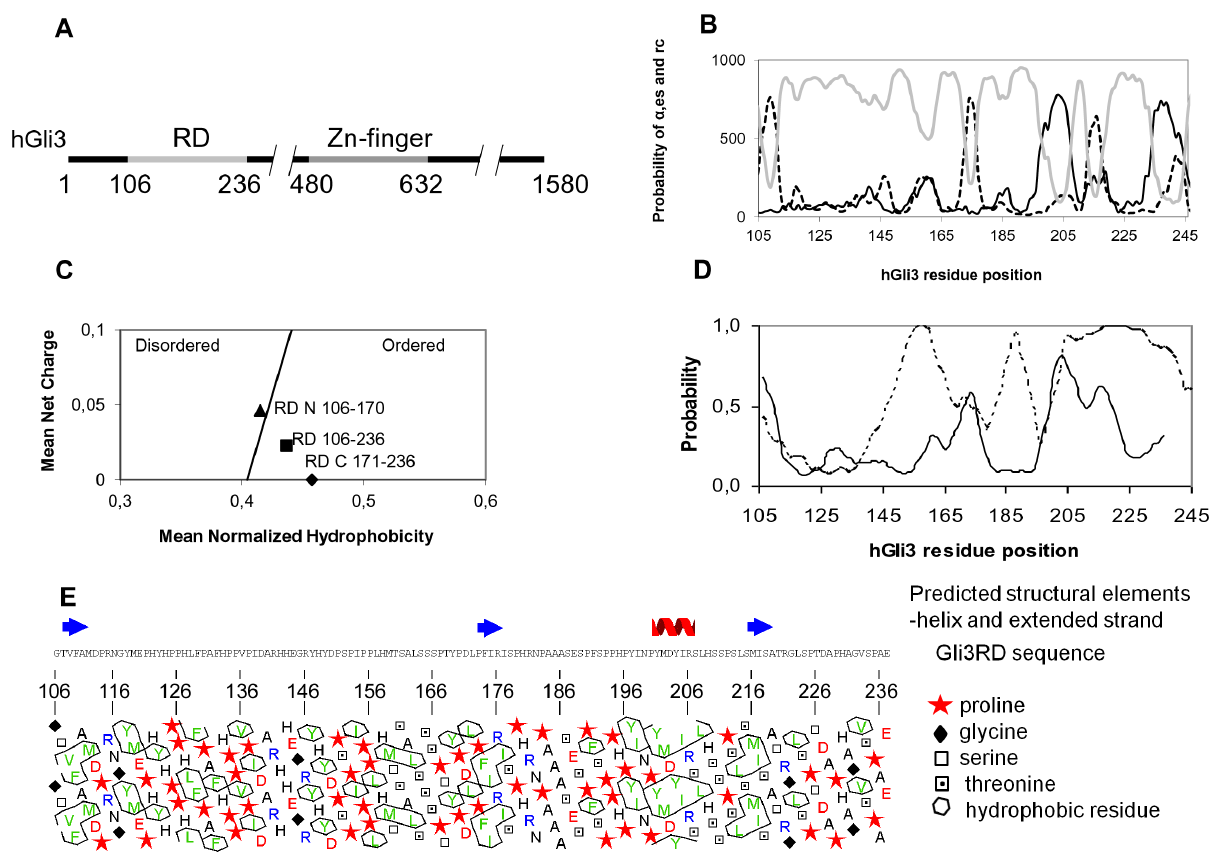
Figure 1. Sequence analysis of human Gli3RD. (A) The relative position of RD within Gli3 from residues G106 to E236. (B) Gli3RD structure prediction with the Hierarchical Neural Network prediction method. The probability for a -helix ( a ) formation is shown with (-), extended strand (—) and random coil (-). (C) Net charge/hydrophobicity plot of the Gli3RD, as well as of the N- and C-terminus shown separately. The charge/ hydrophobicity diagram is divided into two regions by a line (-) corresponding to the equation (R)=2,743(H)-1,109. Proteins on the left and right side of the diagram are predicted to be disordered and ordered, respectively. (D) Prediction of disorder by PONDR (VL XT algorithm) is shown with a dashed line (—) and the binding regions prediction by ANCHOR is indicated with a line (-). (E) The hydrophobisity cluster analysis combined with secondary structure prediction and amino acid sequence of the human Gli3 repressor domain.